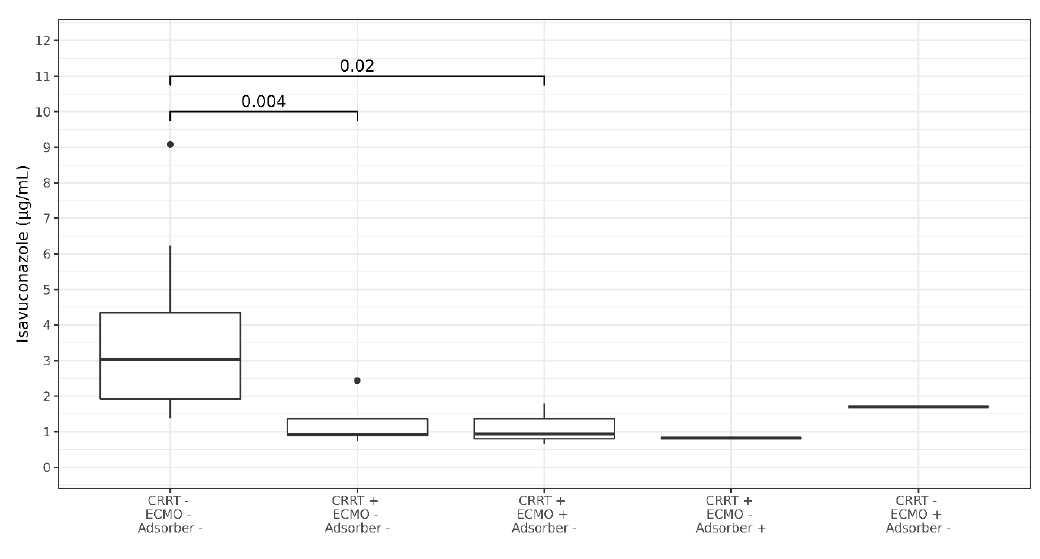
Figure 2. Spaghetti plot of Isavuconazole plasma concentration in patients with and without continuous renal replacement therapy (CRRT).